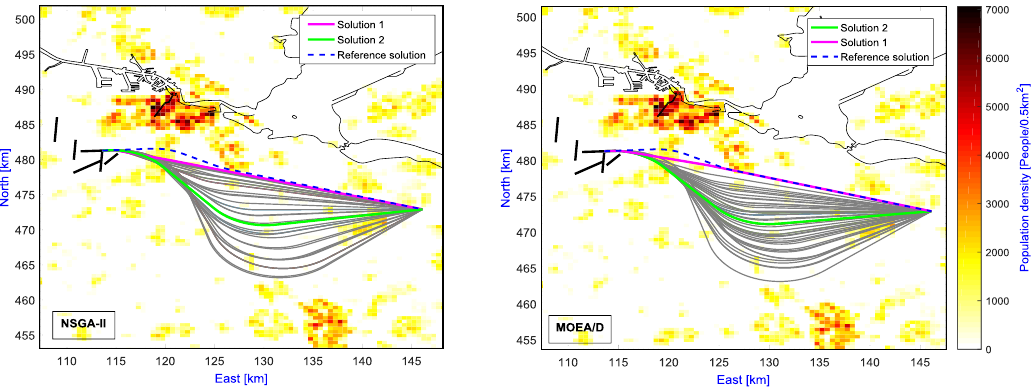
Figure 8. Optimal ground tracks obtained by NSGA-II (left) and MOEA/D (right). Table 2. Comparison of objectives of cases 1–2 and the reference case.